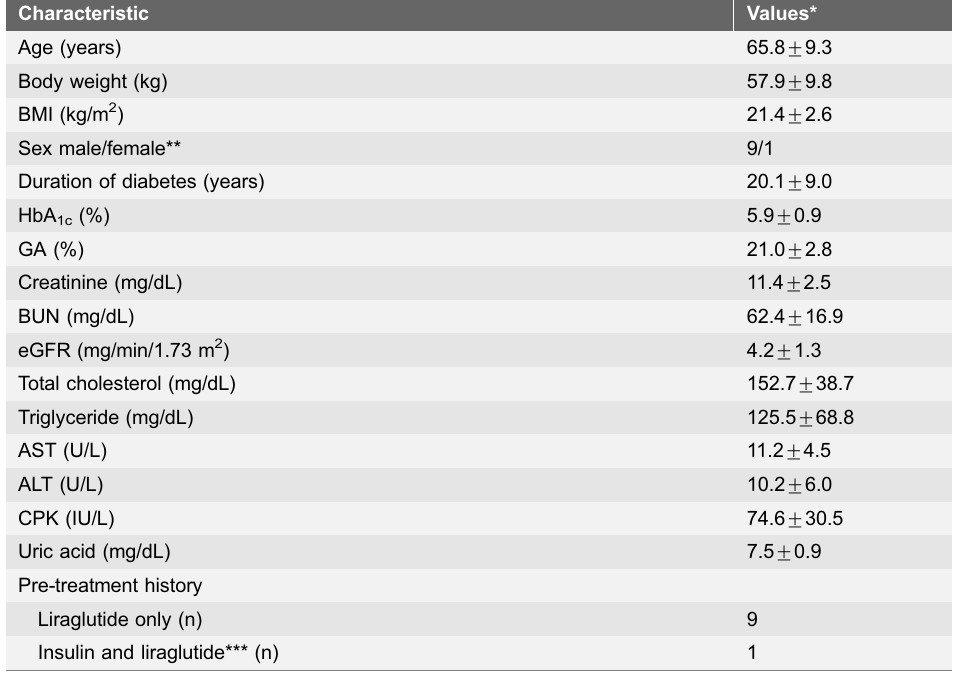
Table 1. Baseline demographics and characteristics of the